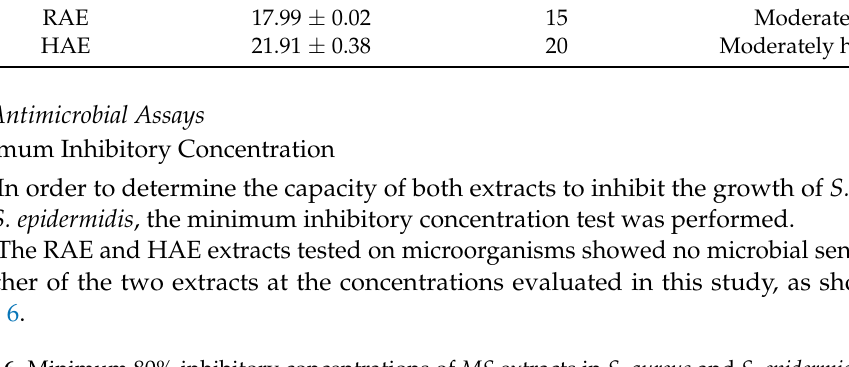
Table 6. Minimum 80% inhibitory concentrations of MS extracts in S. aureus and S. epidermidis .